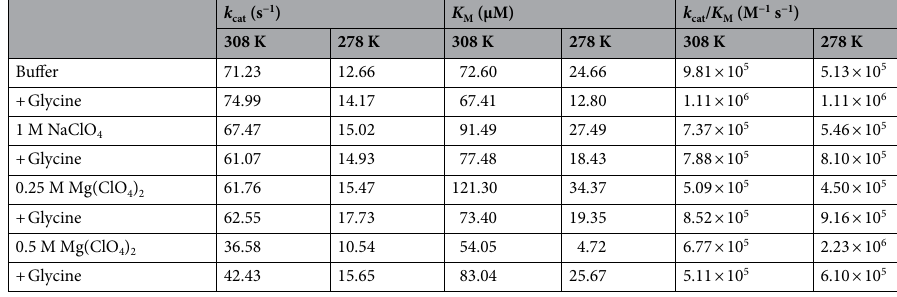
Table 1. α-Chymotrypsin activity values. The turnover number ( k cat ), Michaelis constant ( K M ) and catalytic efficiency ( k cat / K M ) of α-chymotrypsin at 308 K (35 °C) and 278 K (5 °C) in the presence and absence of perchlorate salts and 1 M glycine. Kinetic parameters were determined from the Michaelis–Menten curves of n = 4 replicates.